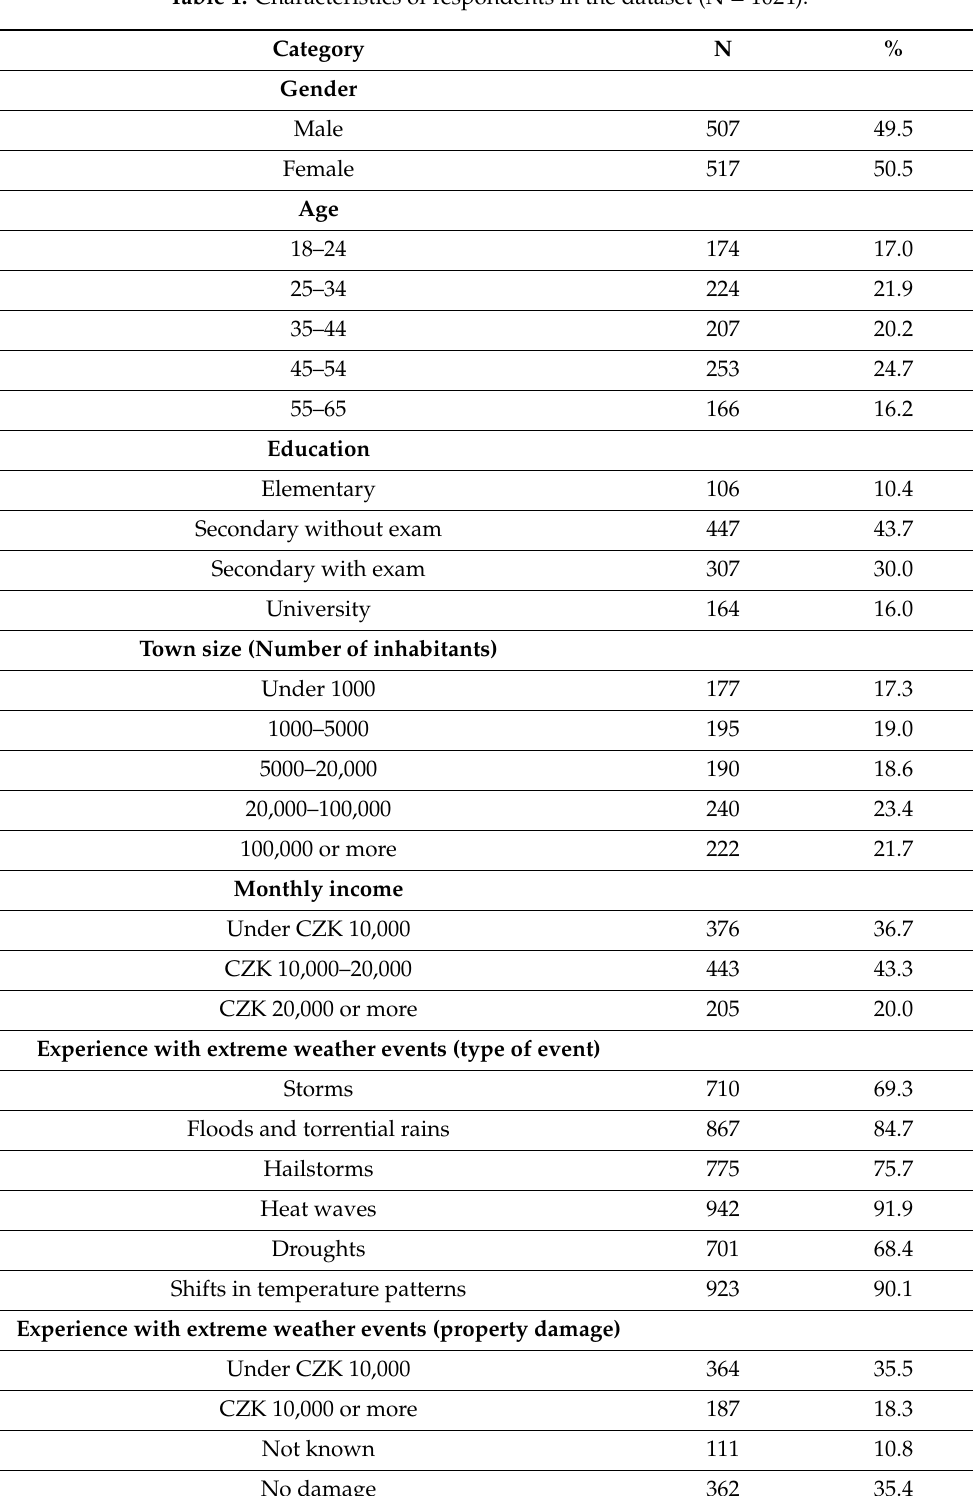
Table 1. Characteristics of respondents in the dataset (N =